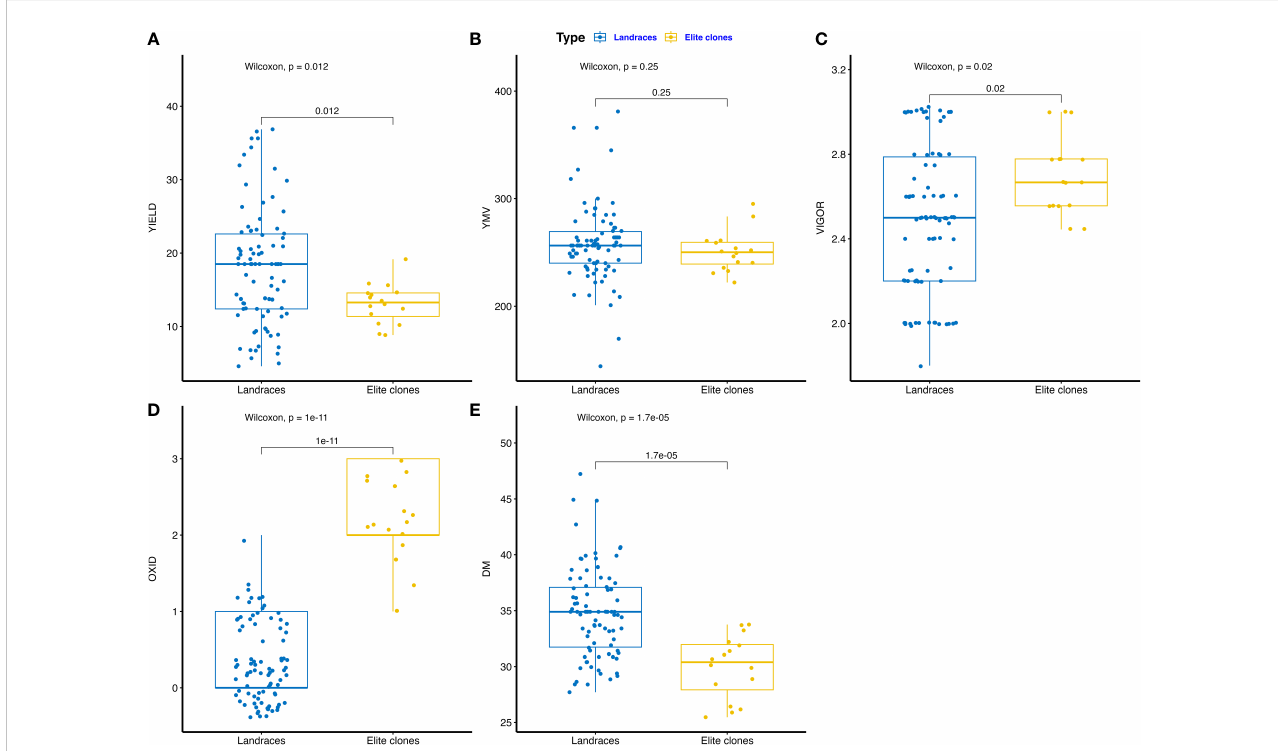
FIGURE 1 Boxplot comparing trait pro fi le of the farmers ’ landraces and elite clones from IITA yam breeding pipelines assessed: (A) tuber yield (t ha -1 ), (B) yam mosaic virus severity (AUDPC value), (C) plant vigor (scale), (D) tuber fl esh oxidation (scale), (E) DM – tuber dry matter (%), YMV – yam mosaic virus, OXID – tuber fl esh